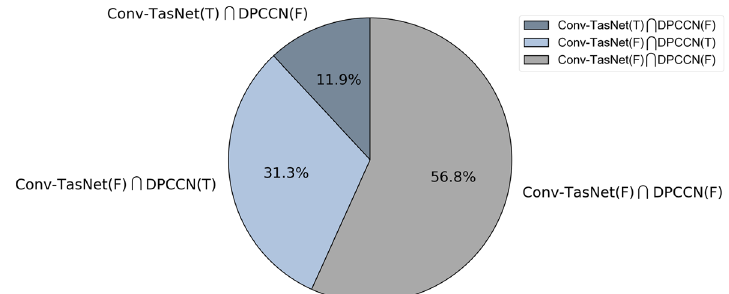
Fig. 6 Detailed separation statistics of the 310 “bad cases” in Aishell2Mix development